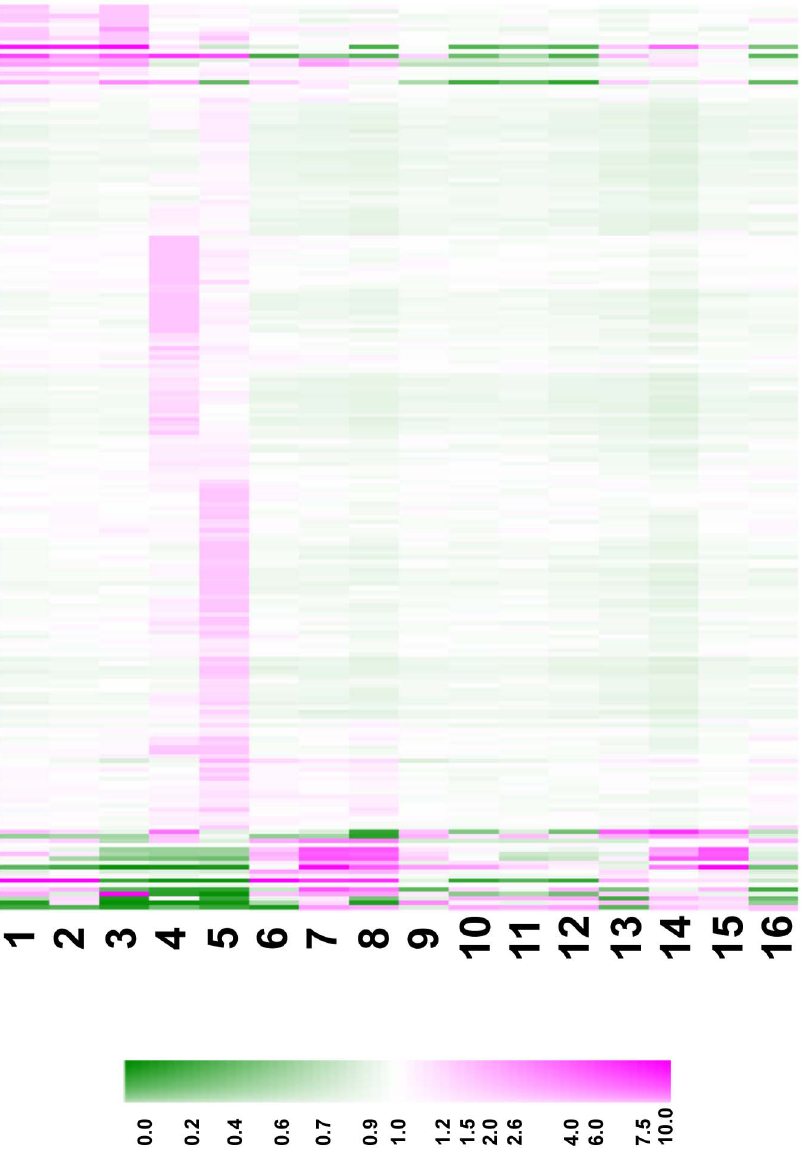
Figure 4. Transcript profiles of expressed Arabidopsis DEFL s and MEG s. Treatments were: (1) 7-d-old seedling, (2) 14-d-old seedling, (3) 21-d- old root, (4) inflorescences, (5) siliques, (6) Col-0 Alternaria mock-inoculation, (7) Col-0 Alternaria -inoculated leaf, (8) dde2-2 Alternaria -inoculated leaf, (9) Pseudomonas mock-inoculation at 3 hpi, (10) Pto DC3000 inoculated leaves at 3 hpi, (11) Pto DC3000 hrcC - inoculated leaves at 3 hpi, (12) Pto DC3000 AvRpt2 inoculated leaves at 3 hpi, (13) Pseudomonas mock-inoculation at 9 hpi, (14) Pto DC3000 inoculated leaves at 9 hpi, (15) Pto DC3000 hrcC - inoculated leaves at 9 hpi, and (16) Pto DC3000 AvRpt2 inoculated leaves at 9 hpi. The heat map shows median scaling of SBQ normalized signal intensity values as described in Materials and Methods. Colors represent high transcript abundance (magenta), low transcript abundance (green), and average transcript abundance (white).